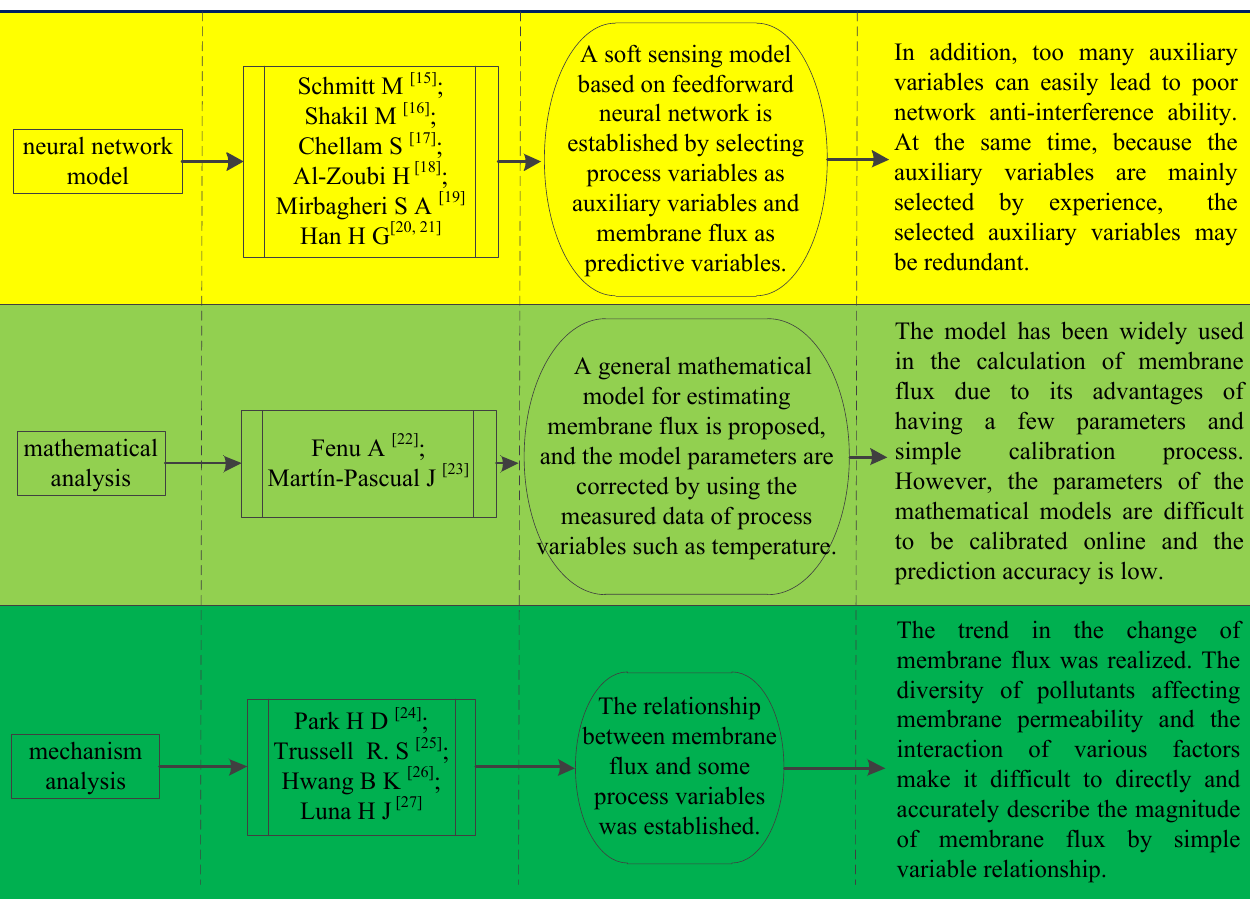
Figure 1. An overview of fouling prediction methods